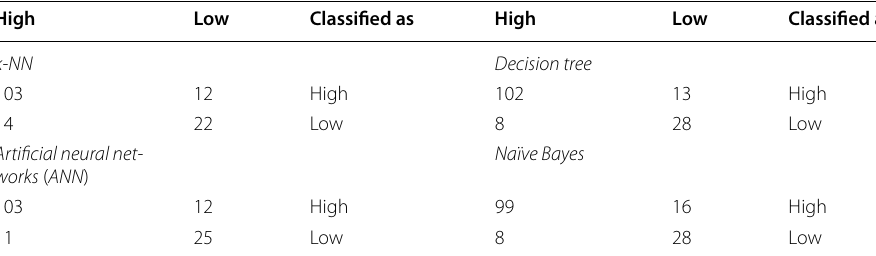
Table 6 Confusion matrixes for prediction